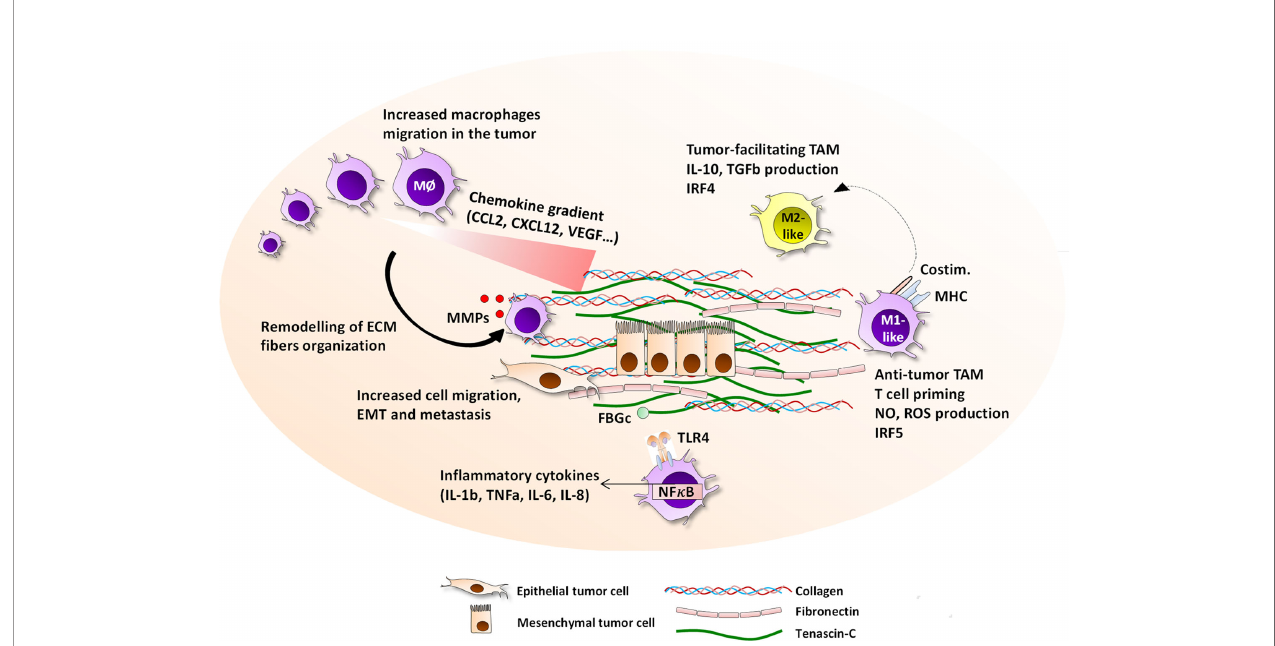
FIGURE 1 | Interactions between the ECM and macrophages in the tumor microenvironment. The tumor-speci fi c ECM network has a panel of possible interaction pathways with macrophages, all of which ultimately impact the evolution of cancer growth and prognosis. ECM molecules including tenascin-C, collagen, fi bronectin, osteopontin, hyaluronan, versican, and thrombospondin, are highly upregulated in primary and metastatic breast cancer and embed epithelial tumor cells, and are produced by tumor cells, CAF, or immune cells. The ECM presence is associated with an increased migration of macrophages to the tumor site, with which they directly interact via the expression of integrins including a M b 2, a 2 b 2, a 2 b 1, a v b 5, or a 9 b 1, or are guided by patterns of chemokine-matrix gradients. On site, macrophages are able to degrade the ECM fi bers by secreting MMP2, 9, 13, and 14, and reorganize the collagen fi bers. Together with their capacity to help cancer cell migration, intra- and extravasation, and initiating the EMT process, ECM help TAM contribute to accelerated metastasis. The ECM network is able to drive TAM towards either pro-angiogenic, anti-tumor M1-like or anti-tumor M2-like phenotype depending of the local contexture. Moreover, the EDA and FBG domains of fi bronectin and tenascin-C respectively are TLR4 ligands that can trigger in fl ammatory responses in myeloid